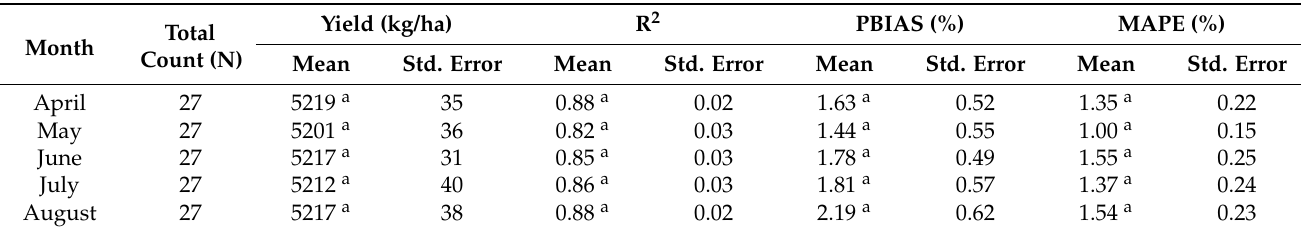
Table 6. Descriptive statistic of ANN cotton yield prediction output and performance using EVI, SPEI12, and CP and CHUs for each